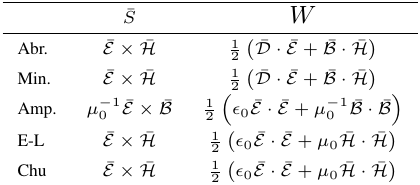
Table 2: Leading electromagnetic energy densities and power